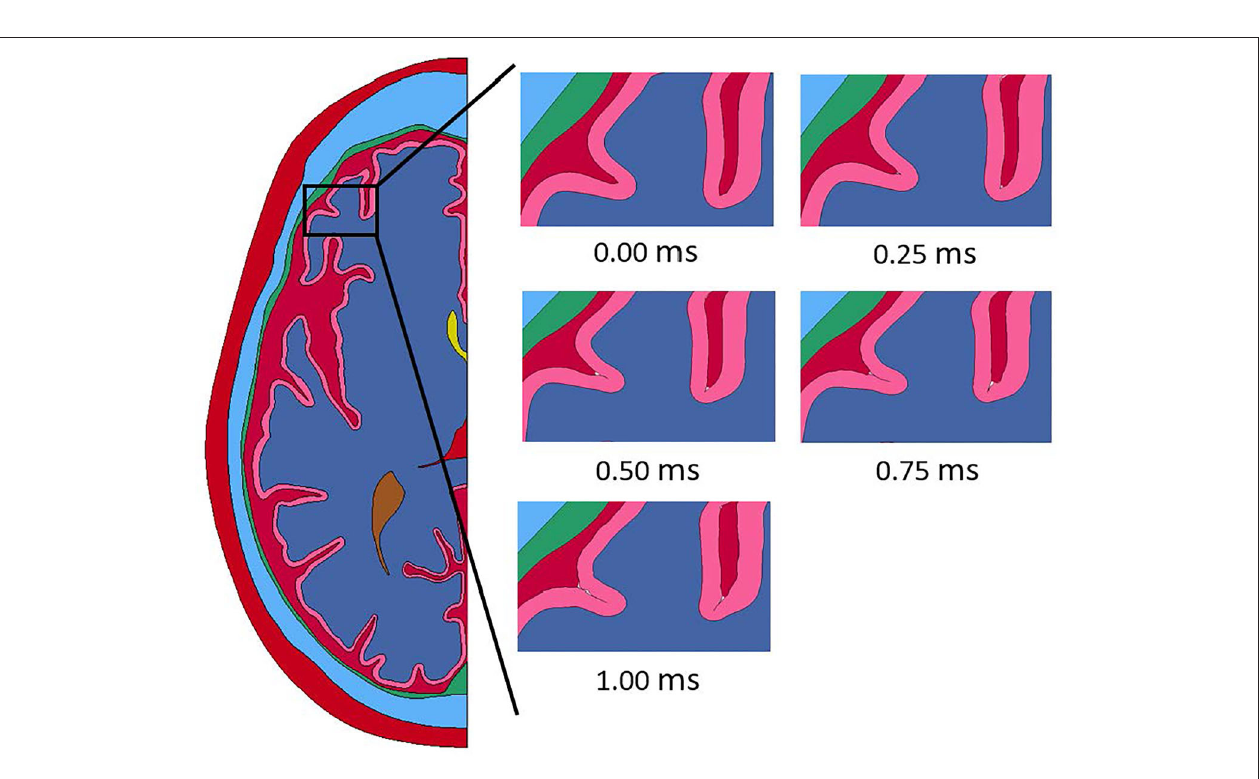
FIGURE 9 | Closure of sulci throughout the duration of the impact event modeled with a differentiated brain homogeneous